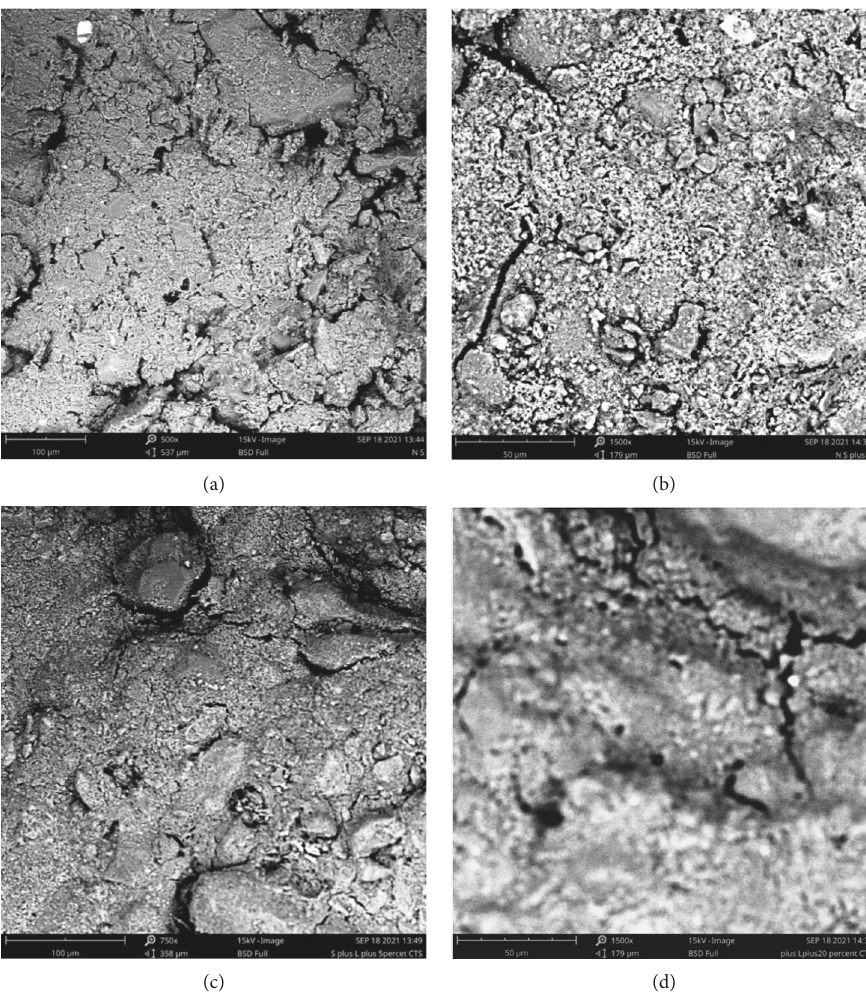
Figure 6: Micrograph of treated and untreated